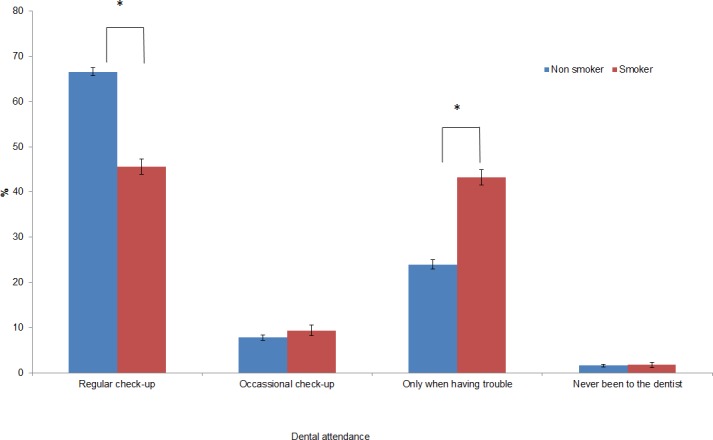
Dental attendance by smoking status (percentage).(error bars indicated 95% confidence intervals) *Significance level 0.05 after Bonferroni correction.